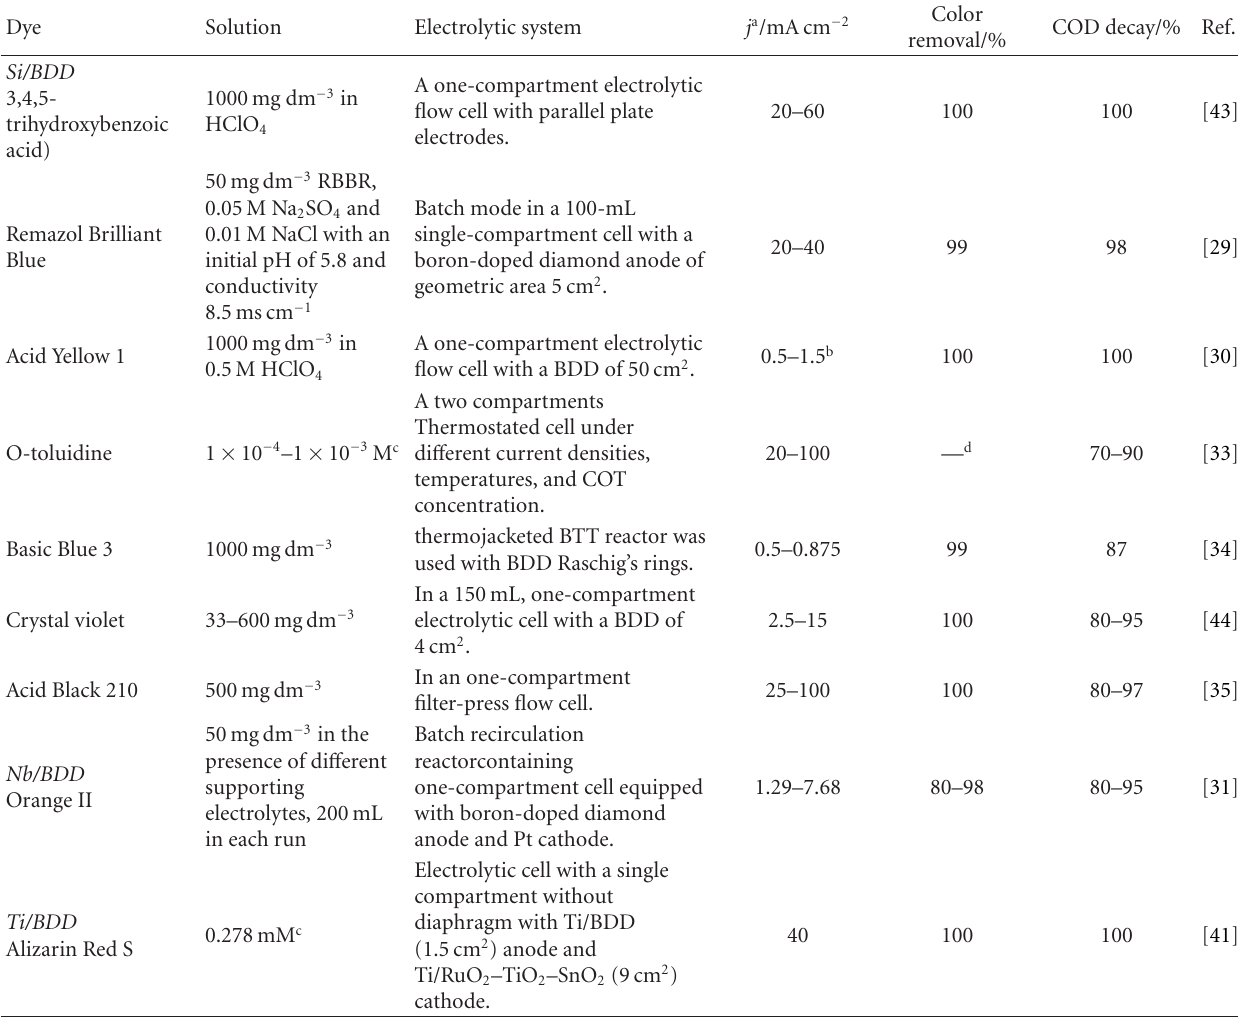
Table 1: Percentage of color removal and COD decay obtained for the electrochemical oxidation treatment with BDD anodes of selected synthetic dyes solutions under optimized conditions at ambient temperature or 25 ◦